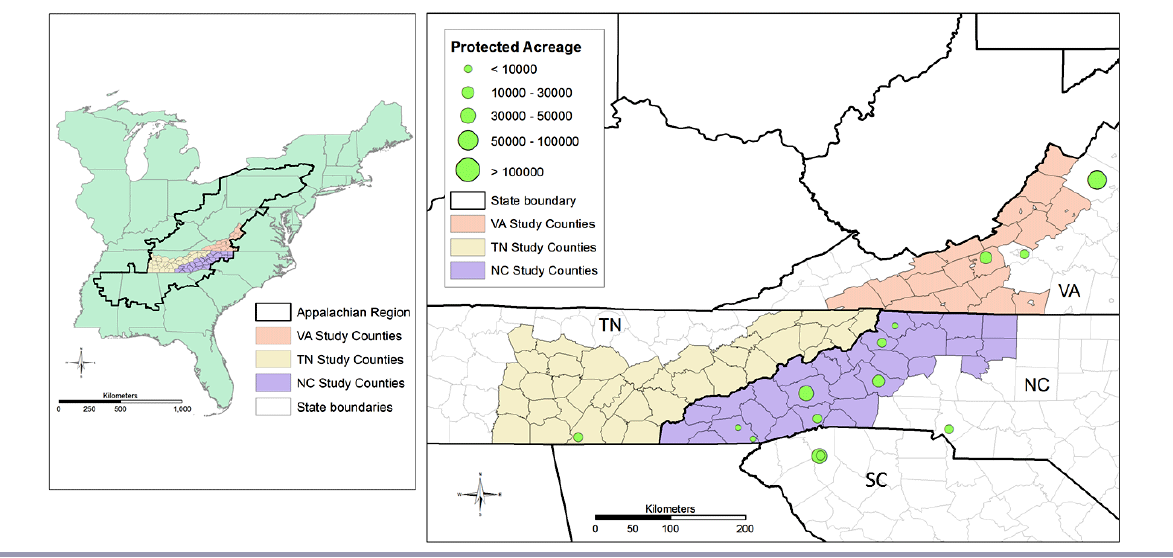
Fig. 2 . Study area showing south-central Appalachian region, study counties, and locations of participating land trusts, by central office and total acreage under conservation easement. Some land trusts maintain a central office in a county outside the study area, but operate in counties that are part of south-central Appalachia (VA = Virginia, TN = Tennessee, NC = North Carolina, SC = South